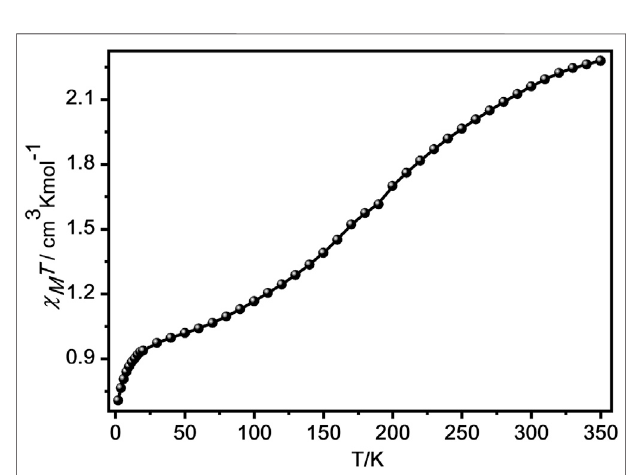
FIGURE 4 | The temperature-dependent of χ M T product in 1,000 Oe for 1 .